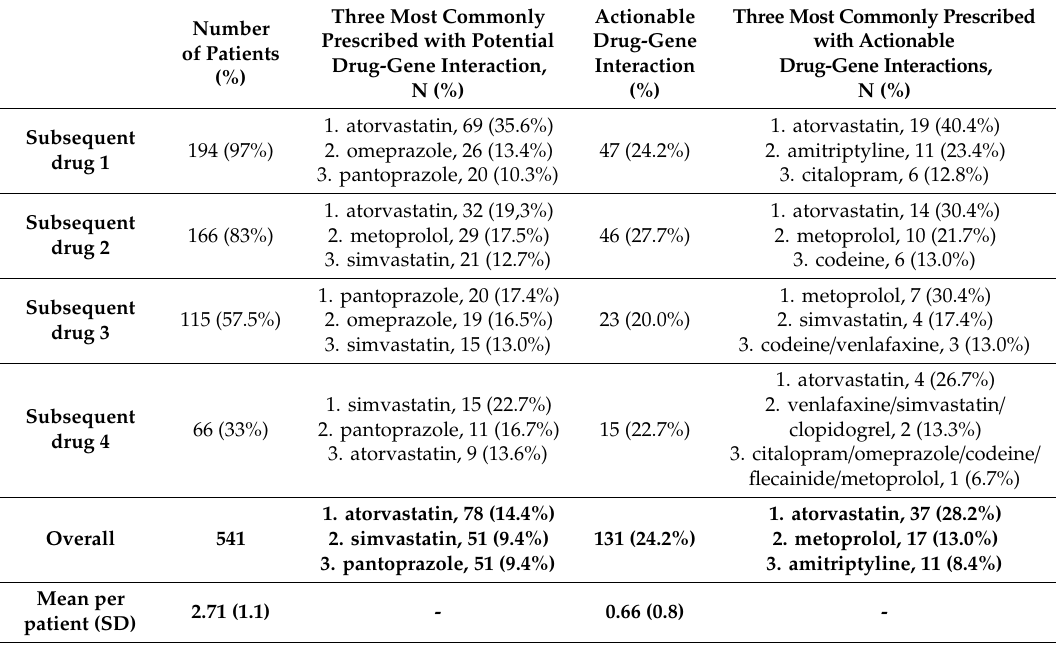
Table 2. Frequency of newly initiated drugs for which there were potential drug-gene interactions in subsequent prescriptions after pharmacogenetics panel in 200 primary care patients with a mean follow-up of 933 days ( = 2.56 years).